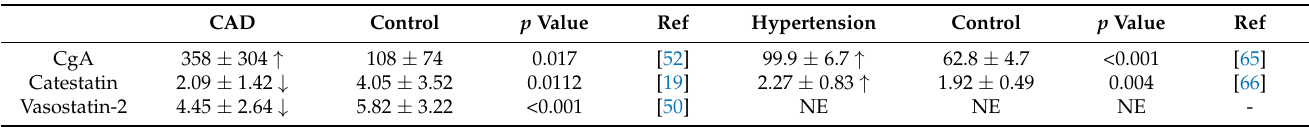
Table 2. Circulating concentrations (ng/mL) of CgA, catestatin, vasostatin-2 in coronary heart disease (CHD) and hyperten-